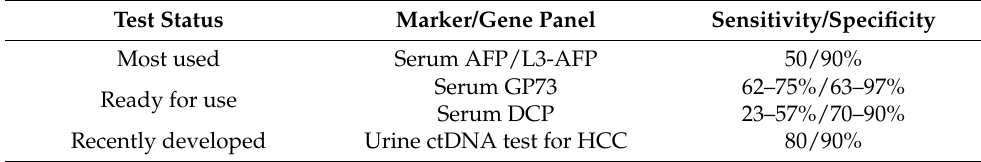
Table 4. Comparison of urine ctDNA test to other commonly used tests for HCC